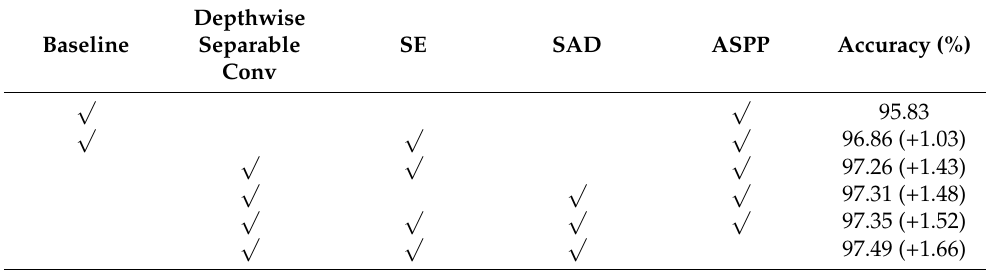
Table 4. Comparison among the different combinations of the introduced modules on the CULane validation set. The baseline means the RESNET-18.